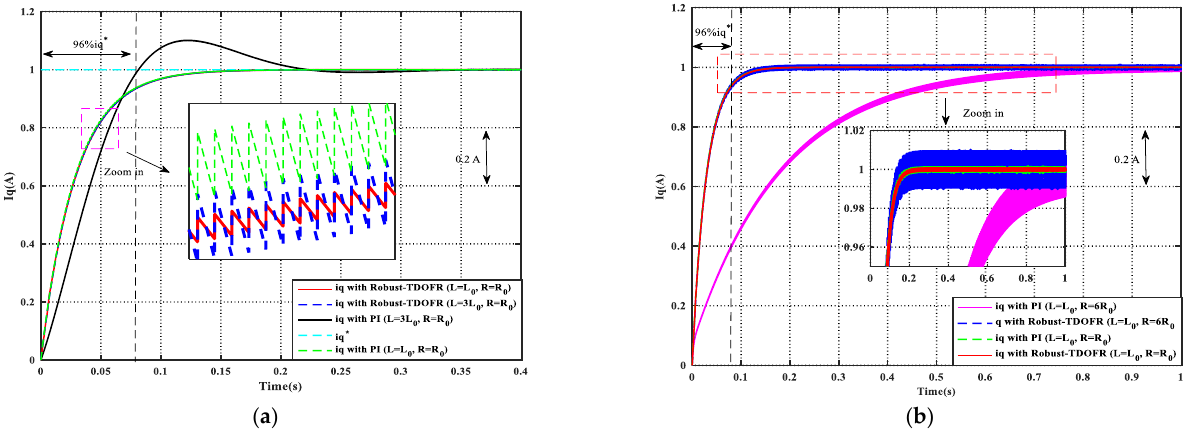
L = 3L , R = R and ( b ) step response 0 0 L = L , R = 6R . 0 0